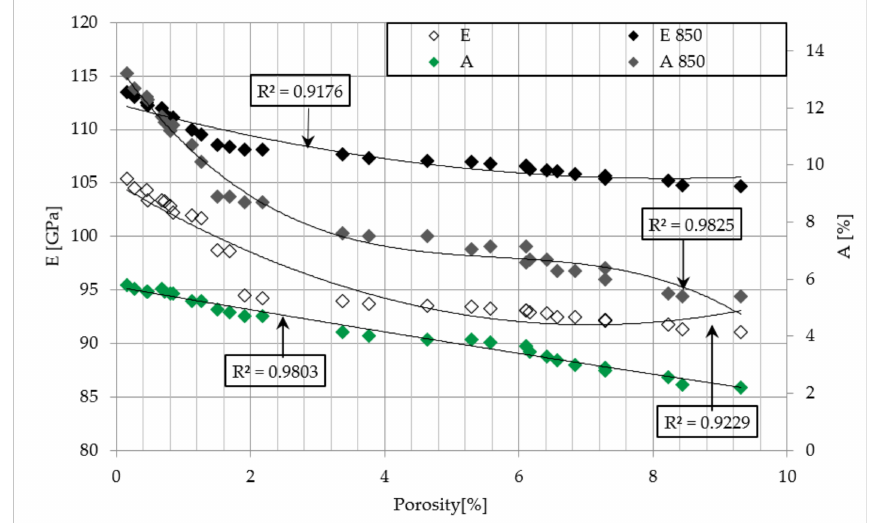
Figure 12. Influence of porosity on Young modulus and elongation of as-build and heat treated at 850 ◦ C